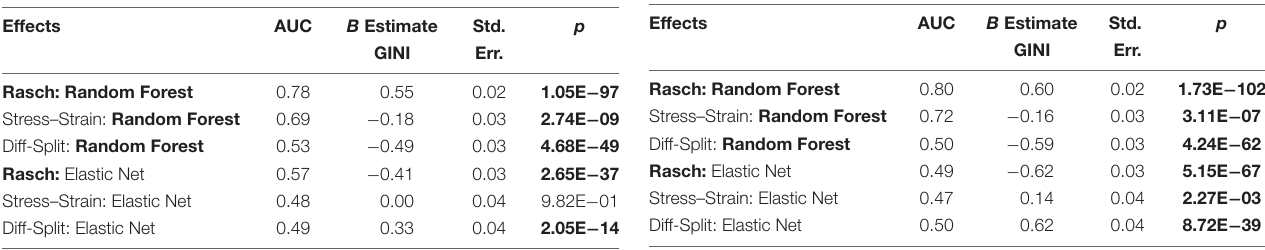
TABLE 3 | Working memory transfer.